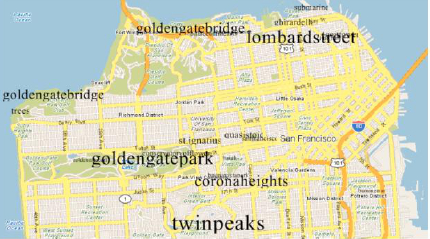
Figure 2. Tag clouds on San Franciso(Jaffe and Naaman 2006)